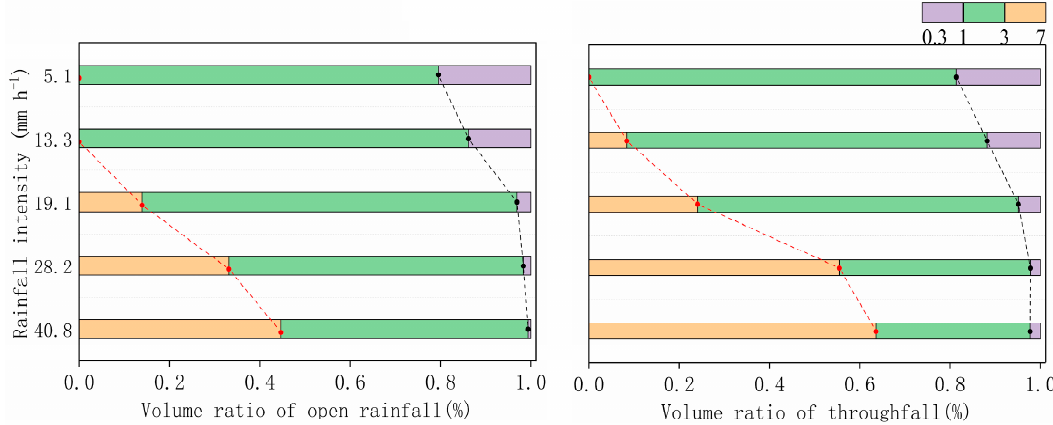
Figure 5. Volume ratio of raindrops with different size raindrops under different rainfall intensity. The dashed, red lines indicate the volume ratio of large drops, and the dashed, black lines represent the volume ratio of small drops.